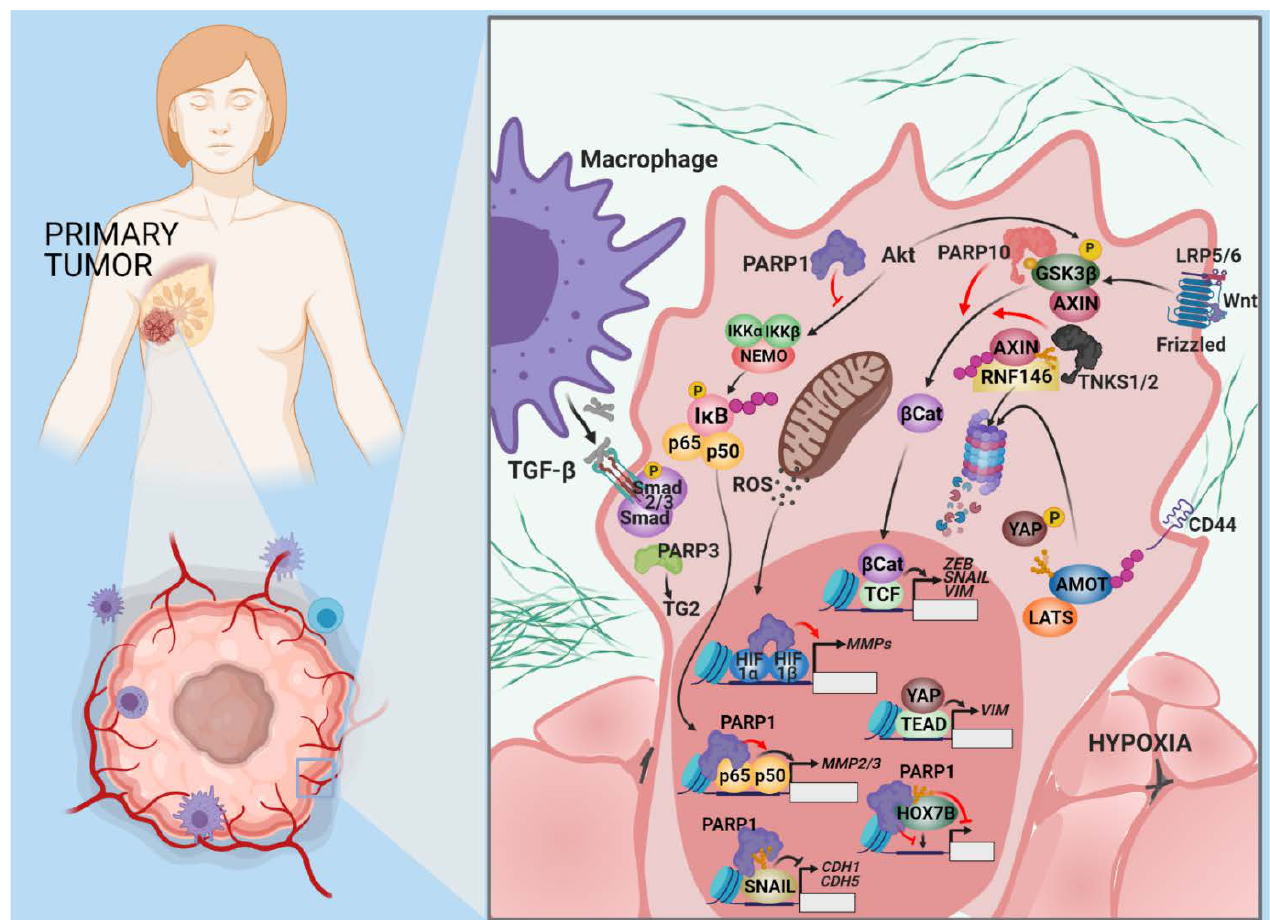
Figure 2. The association of PARPs with tumor cell invasion. Tumor cell invasion begins with EMT, a phenotypic transformation of the tumor cells. PARPs can have opposing effects on EMT. The Hippo pathway suppresses metastasis initiation by regulating the transcription factor, YAP, through the AMOT protein family members. TNKS1 and TNKS2 inactivate the AMOT proteins in a manner similar to their effect on AXIN, allowing the accumulation, nuclear translocation, and transcriptional engagement of YAP. PARP-1 interacts with HOXB7, another EMT-promoting transcription factor, and reduces its transcriptional activity. PARylation of Smad proteins by PARP-1 and -2 hinders TGF- β signaling. The PARPs are also involved in restructuring the ECM, which is necessary for the growth and dissociation of a tumor. Upregulation of PARP-1 has been connected to the transcriptional induction of MMP2 and 9 and the downregulation of TIMP. These effects are probably achieved through the stimulation of NF- κB transcription factors. PARP-1 is involved at multiple levels in the positive regulation of SNAIL1, one of the most important transcription factors driving dedifferentiation associated with EMT.